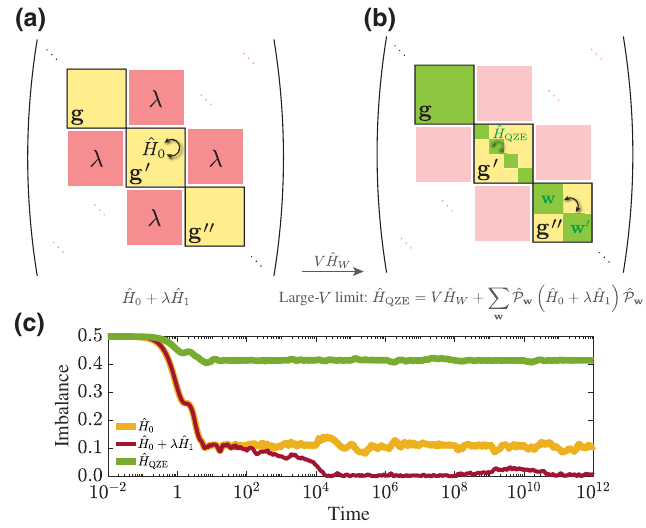
FIG. 1. The concept of local-pseudogenerator protection of disorder-free localization and its enhancement through dynam- ically emergent local symmetries. (a) An ideal gauge theory ˆ H 0 of L matter fields and L gauge fields hosts a gauge symme- ˆ try with local generator G j whose eigenvalues are g j , a set of which over all local constraints defines a superselection sector ˆ P g = ( g 1 , g 2 , . . . , g L ) with projector g (yellow blocks). Gauge ˆ invariance is encoded in the commutation relation [ ˆ H 0 , G j ] = 0 for all j . Disorder-free localization emerges in the quench dynamics of an initial state prepared in a superposition of super- selection sectors. A typical quantum synthetic matter realization of ˆ H 0 will include gauge-breaking errors λ ˆ H 1 of strength λ that will couple the different superselection sectors g , and undermine localized behavior (off-diagonal red blocks). (b) The local pseu- ˆ dogenerator ˆ W j acts identically to G j in a given superselection sector (congruent yellow and green blocks), but not necessar- (cid:2) ily outside of it. The addition of the term V ˆ H W = V c j ˆ W j j of strength V , with c j a properly chosen sequence (see the main text), will suppress transitions between different superselection sectors g , thereby protecting localization due to the quantum Zeno effect. At sufficiently large V , errors are suppressed and the dynamics is effectively propagated by the emergent gauge theory (cid:2) ˆ P ˆ H = V ˆ H + ( ˆ H + λ ˆ H ) ˆ P QZE 0 1 W w w , which has an enhanced w local symmetry associated with ˆ W j , and contains the original ˆ Z G j . The eigenvalues w j of 2 gauge symmetry generated by ˆ W = ( w . . . , w ) 1 , w 2 , j define emergent superselection sectors w L ˆ P with projectors w (green blocks). The initial state is a super- position of the superselection sectors w , leading to a greater effective disorder over superselection sectors, thereby enhanc- ing disorder-free localization under ˆ H QZE . (c) Starting in a translation-invariant bosonic domain-wall state that is a super- position over all gauge superselection sectors, the dynamics of the imbalance under ˆ H 0 will retain memory of the initial state (yellow curve). Errors λ ˆ H 1 cause the system to thermalize (red curve). Adding V ˆ H W in the large- V limit dynamically induces the emergent theory ˆ H QZE with an enriched local symmetry, thereby enhancing disorder-free localization (green curve; see Sec.